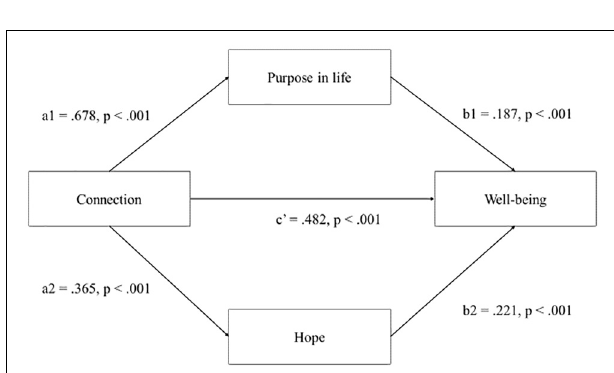
FIGURE 2 | Test of indirect associations in regards to purpose in life and hope as indirectly associated with connection and